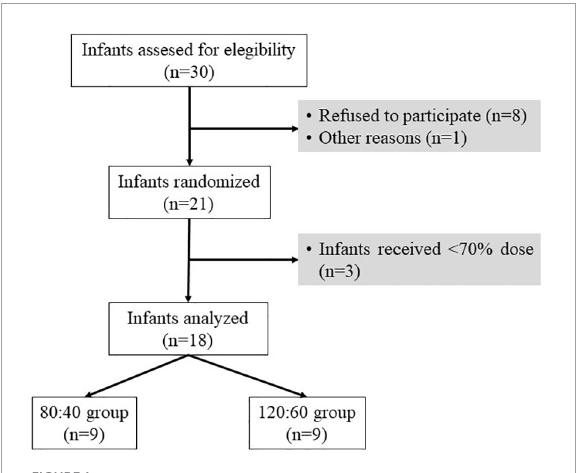
FIGURE1 Flowchart of the allocation of eligible study infants. Sample size ( n ). Other reasons including congenital malformation or inborn errors of